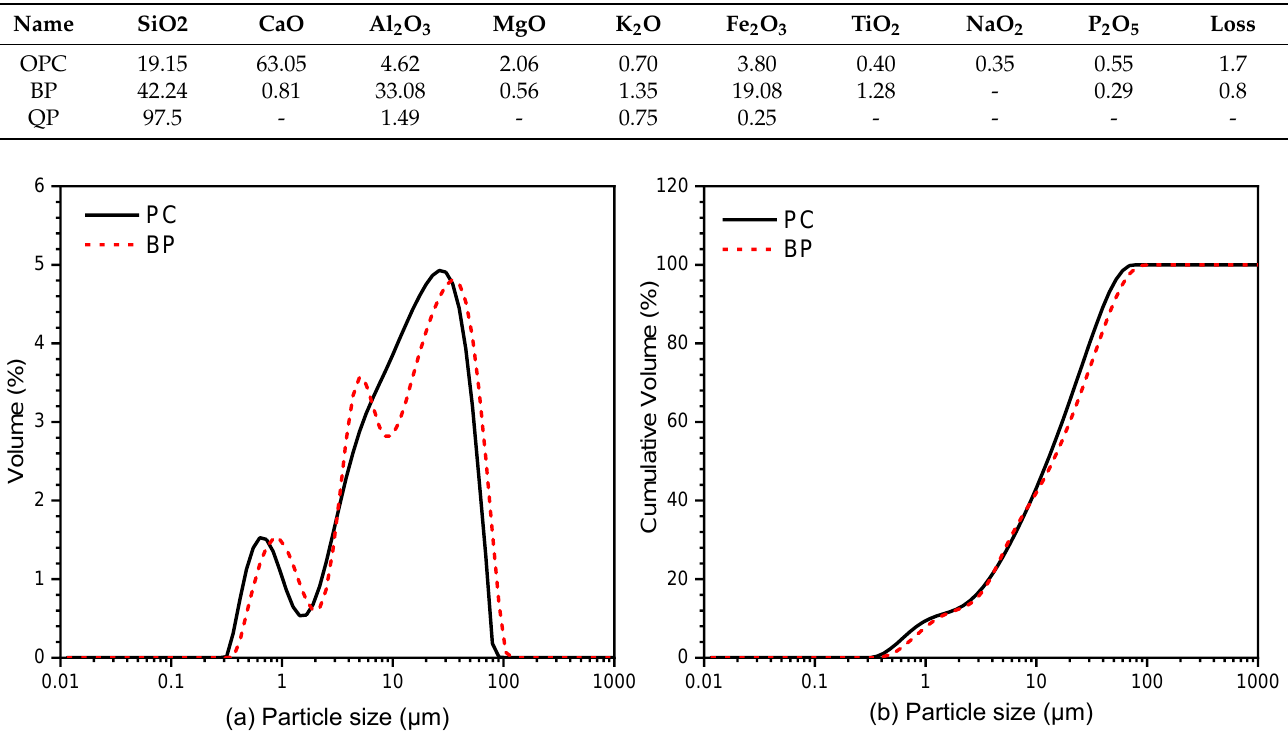
Table 1. Chemical compositions of materials (%).